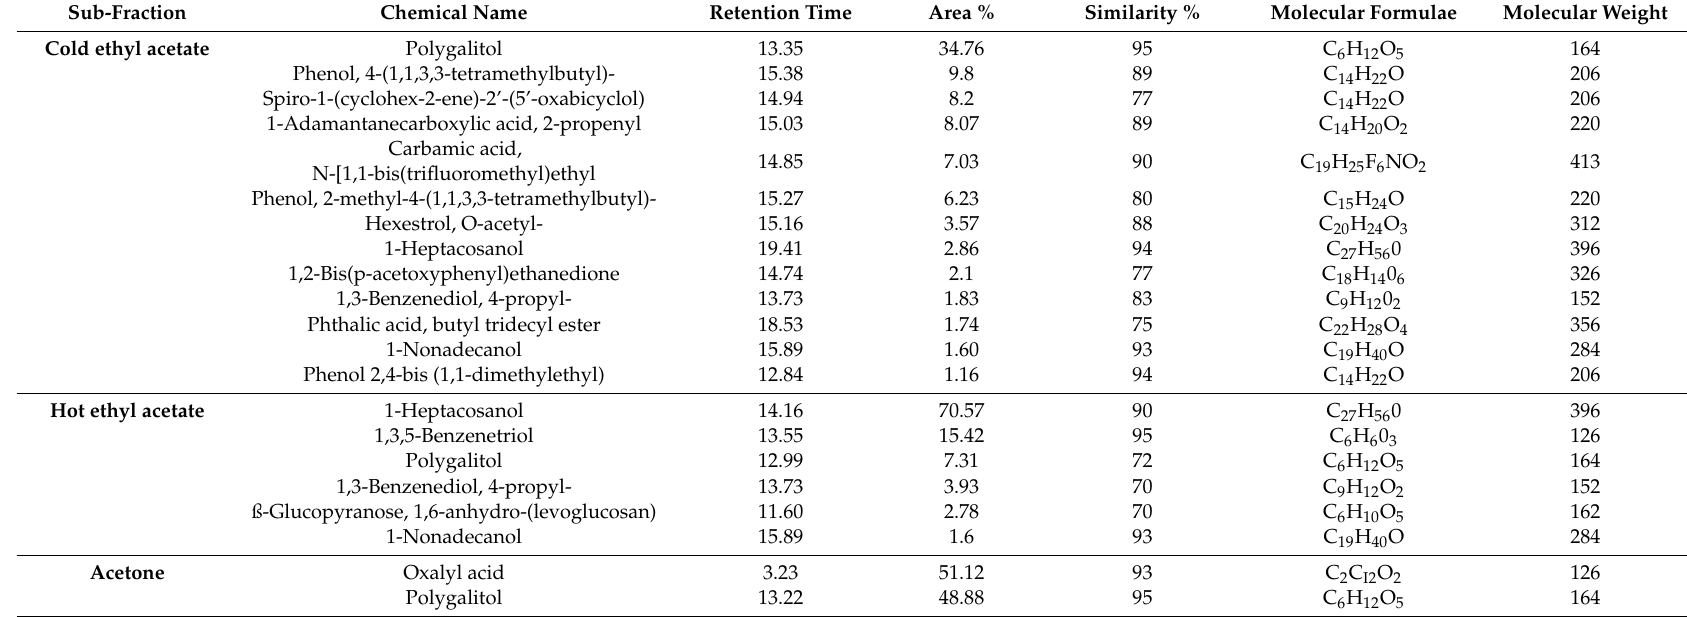
Table 3. Gas Chromatograph-Mass Spectroscopy (GC-MS) data of phytocompounds putatively identified in di ff erent sub-fractions of methanolic extracts of Protea ca ff ra